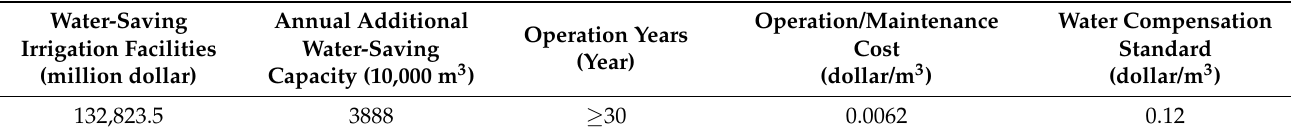
Table 6. Calculation of relevant parameters of water compensation standard based on restoration cost method. Water ‐ Saving Irrigation Facilities (million dollar)